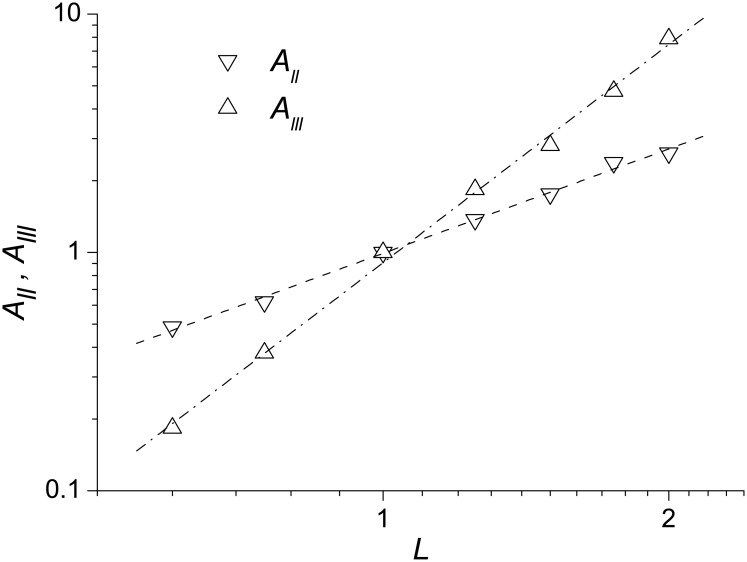
Prefactors All and Alll determining the structure function scaling with the coarse-graining length L.Triangles-down and triangles-up are for the structures of the second and third orders, respectively. The dashed and dash-dot lines represent the best-fits of All and Alll to the equations All ∼ LDll and Alll ∼ LDlll (Dll ≈ 1.45 and Dlll ≈ 3.0).